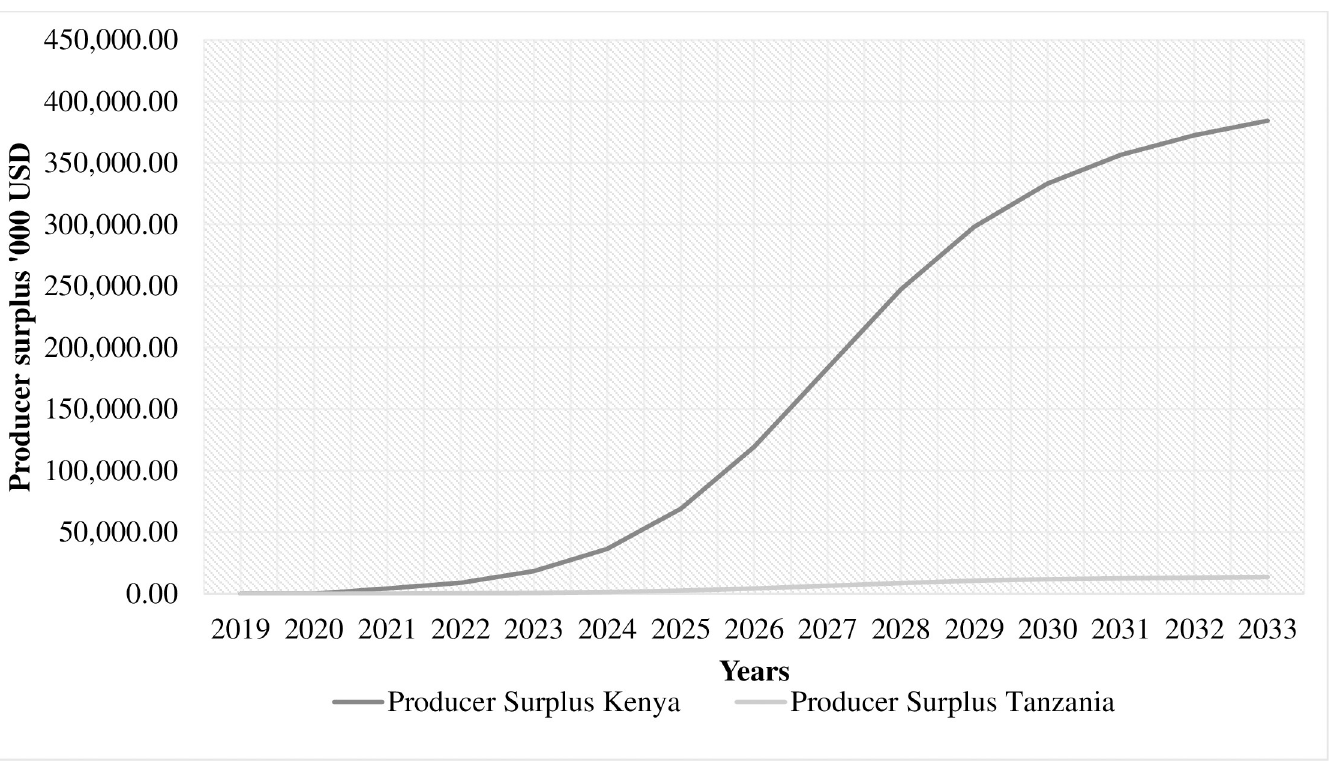
Fig 2. A comparison of economic surplus over time between Kenya and Tanzania due to Integrated Pest and Pollinator Management intervention in avocado production.